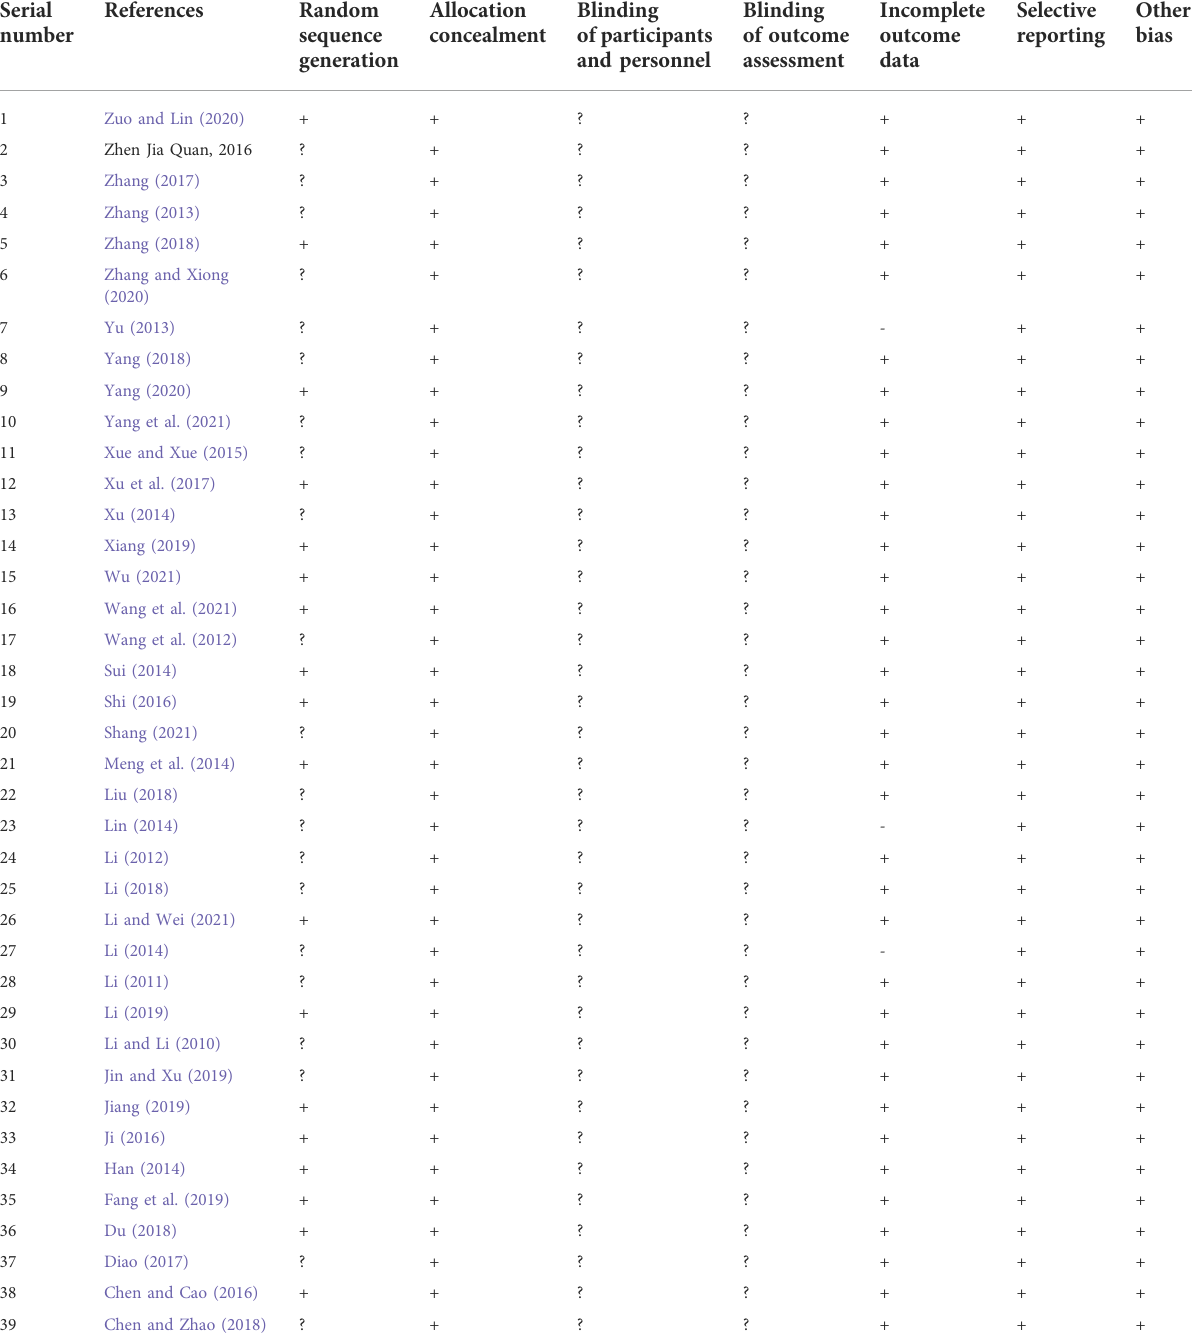
TABLE 3 The methodological quality of the included trials assessed using the Cochrane Risk of Bias